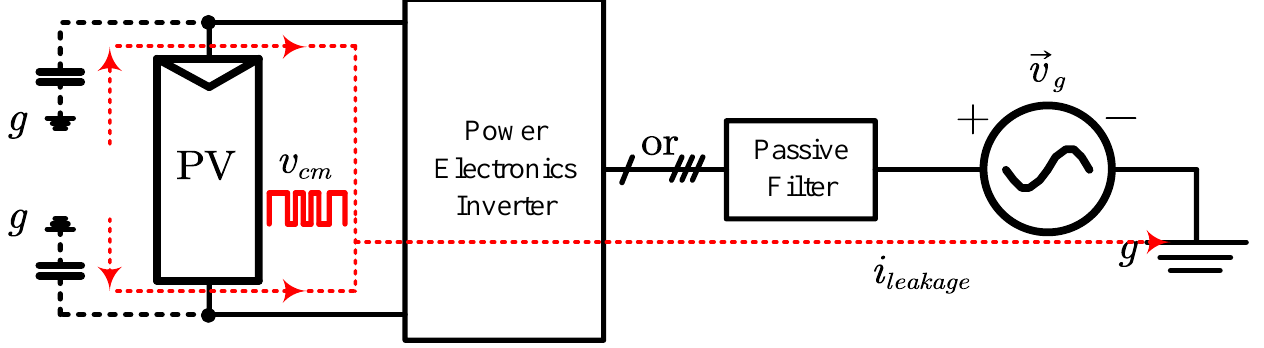
Figure 1. Impact of HF-CMVs on transformerless PV system.